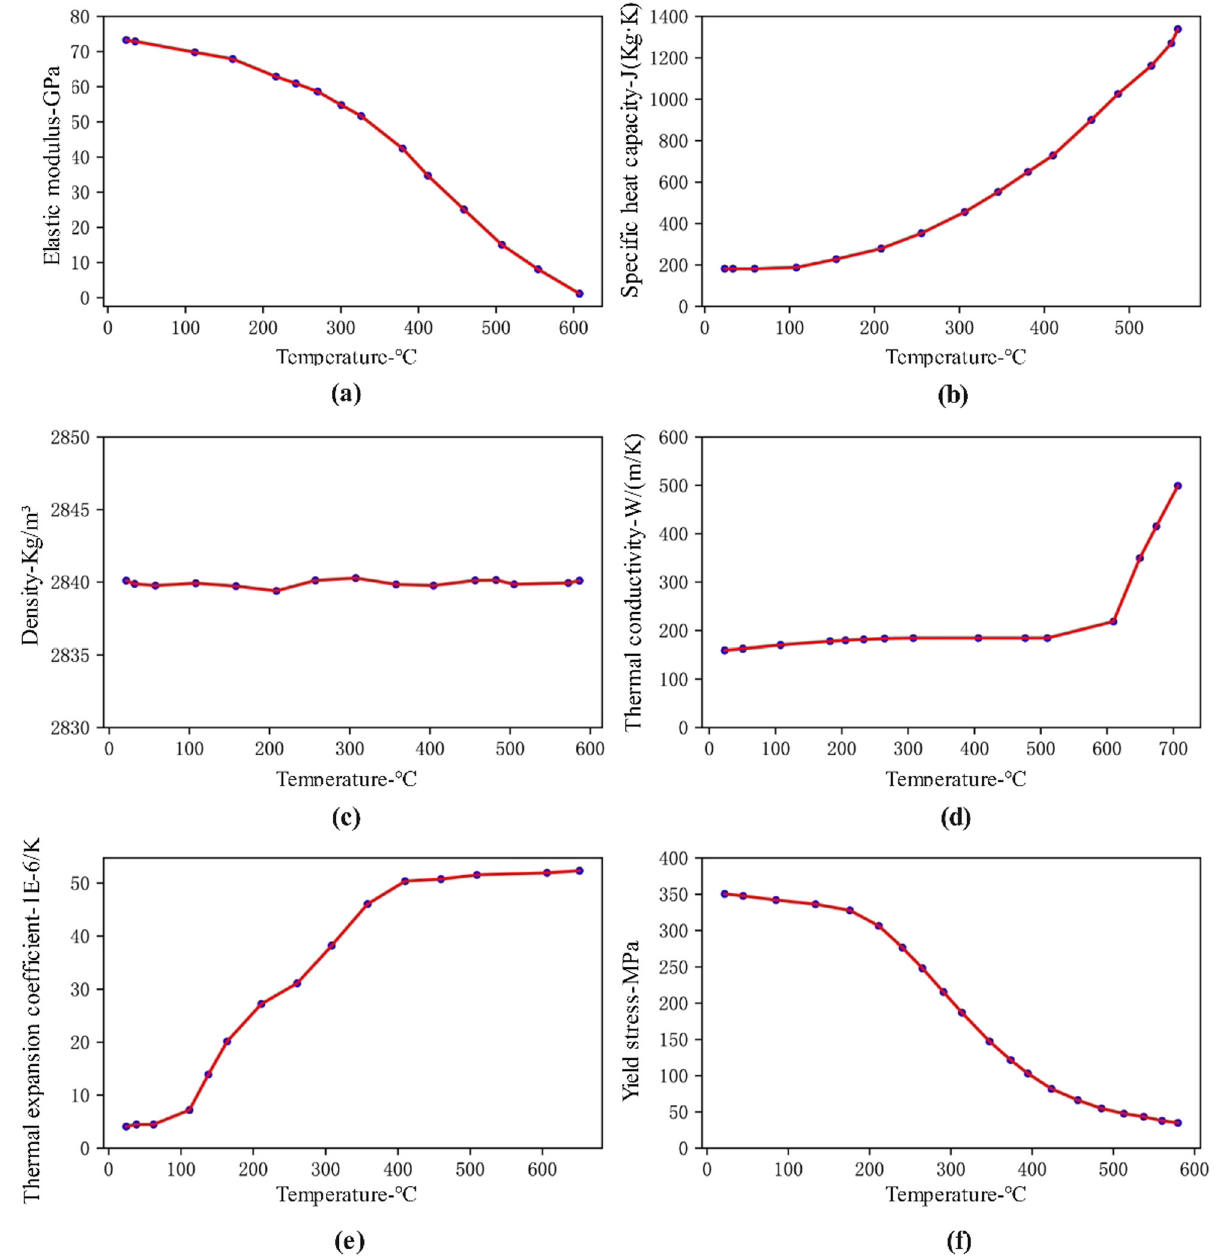
Figure 6: Thermophysical parameters of 2219 aluminum alloy [ 38 – 40 ] : ( a ) elastic modulus; ( b ) speci fi c heat capacity; ( c ) density; ( d ) thermal conductivity; ( e ) thermal expansion coe ffi cient; ( f ) yield